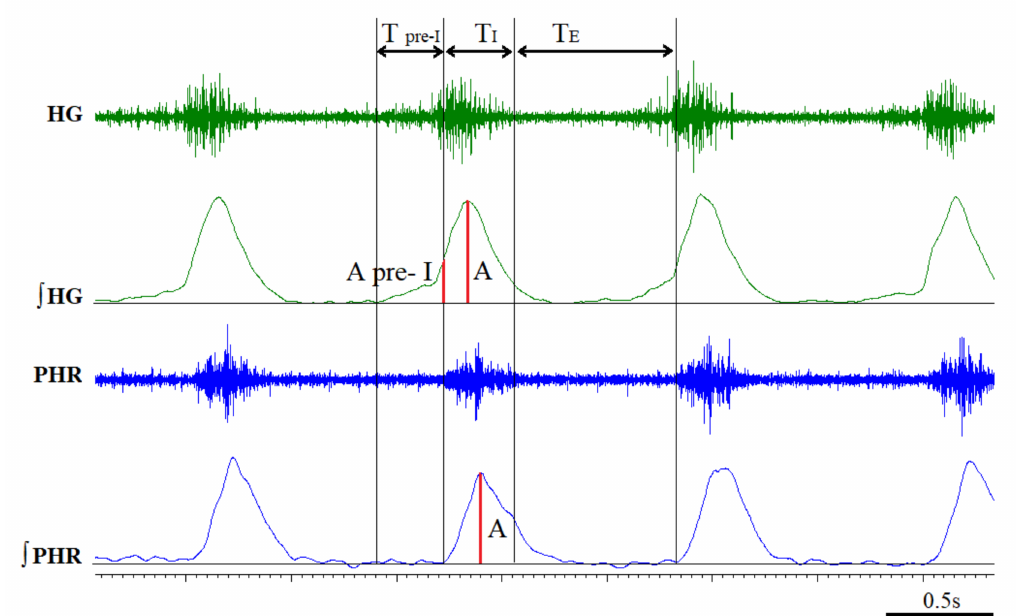
Figure 1. Sample record of neurograms of the hypoglossal nerve (HG, XII nerve) and the phrenic nerve (PHR) showing the calculation method of the following parameters: inspiratory time (T I ), expiratory time (T E ), pre-inspiratory time of HG nerve activity (T pre-I), the amplitude (A) of HG and PHR, amplitude of HG pre-inspiratory activity (A pre-I